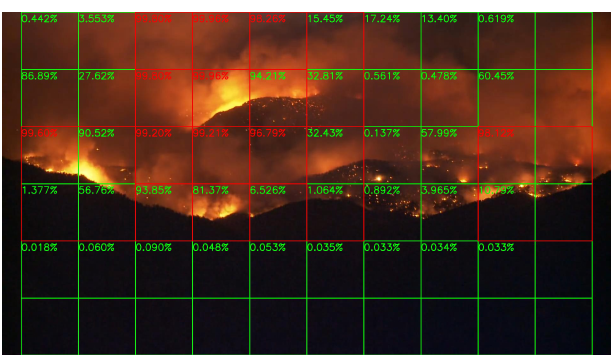
Figure 16. Boulder Colorado Fire, 6 September 2010.